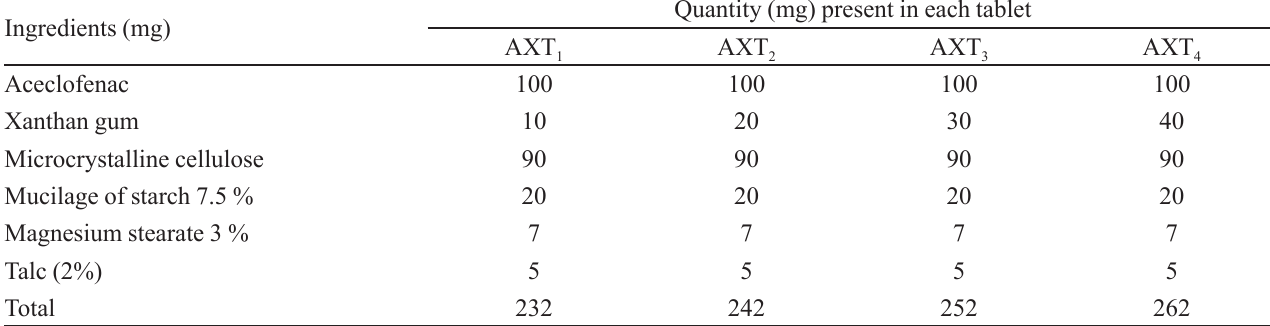
TABLE I - Composition of aceclofenac tablet Ingredients